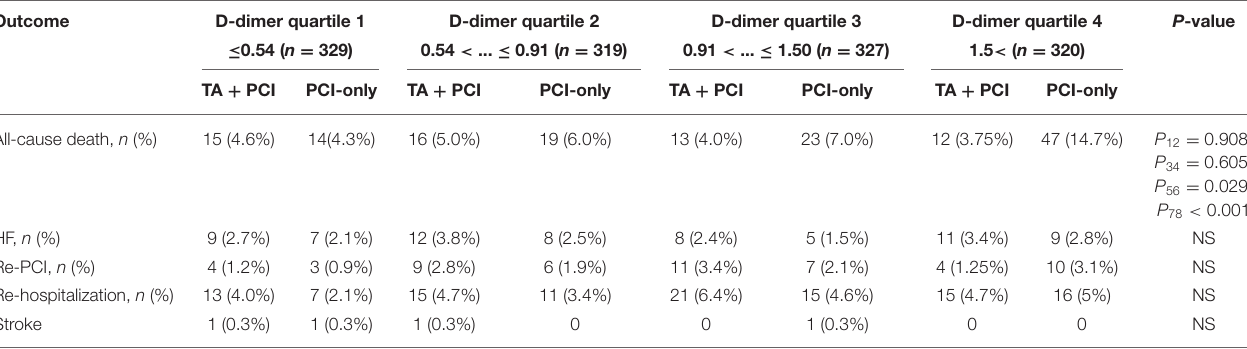
TABLE 5 | Primary and secondary end points for the subgroup analysis with different levels of